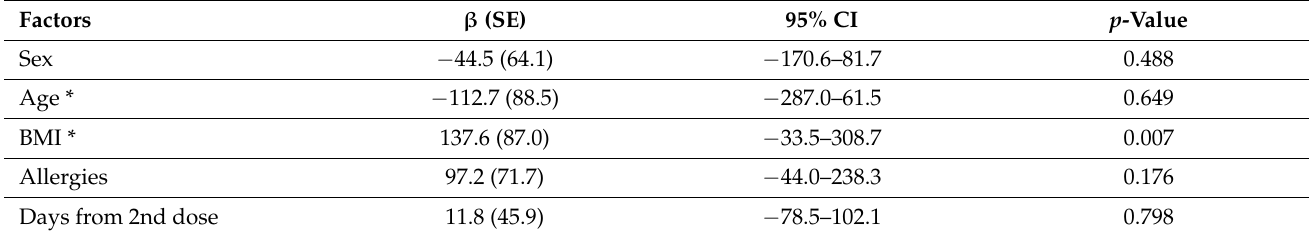
Table 2. Univariable analysis of the association between anti-SARS-CoV-2 titers and sample characteristics (all participants).